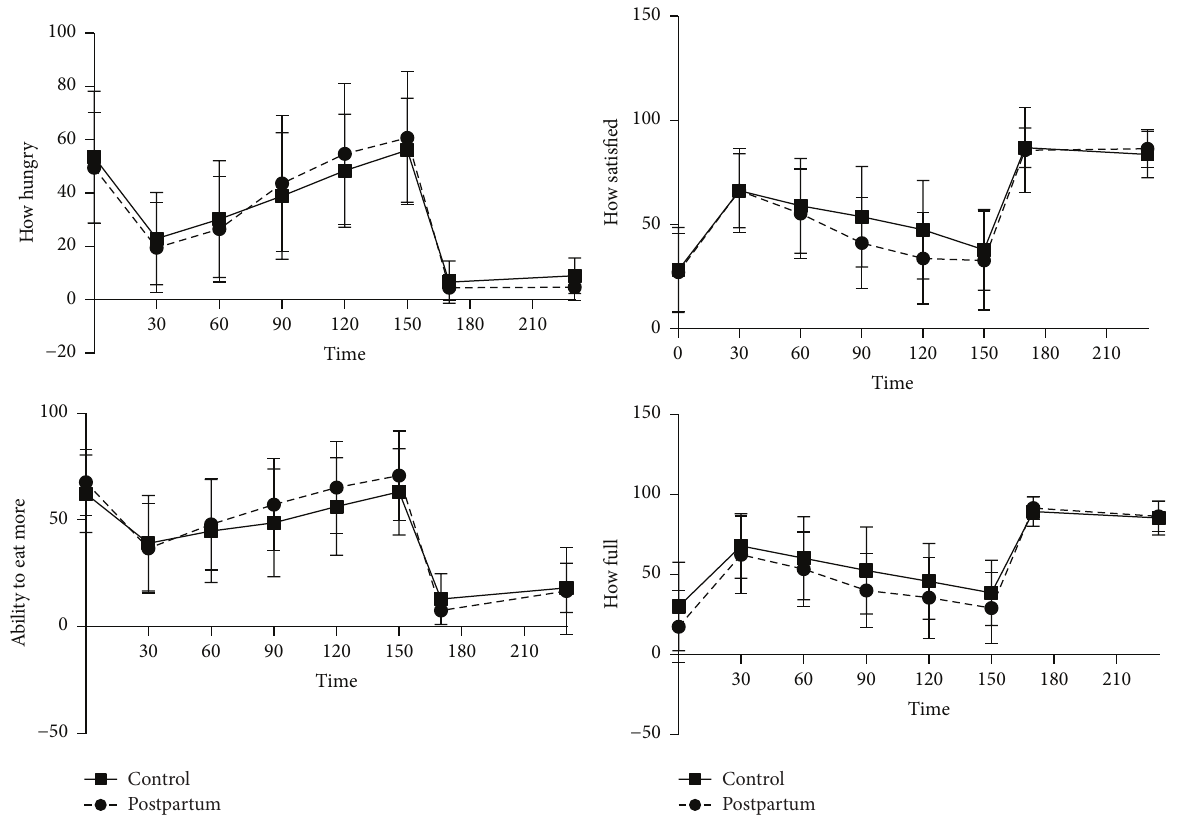
Figure 3: Ratings of hunger, satiety, fullness, and motivation to eat during fasting (time 0) and in response to a standardized breakfast meal in 24 postpartum lactating women (circles, dashed lines) and 20 never-pregnant control women (squares, solid